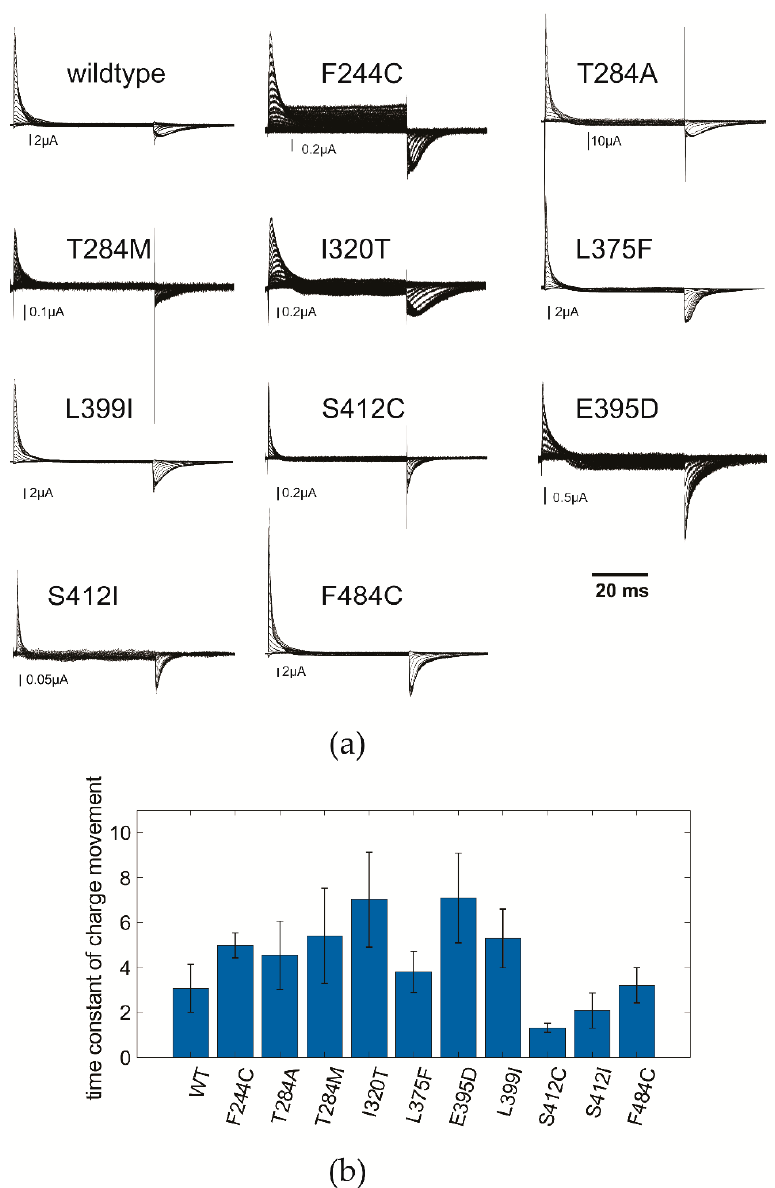
Figure 2. ( a ) Gating currents elicited from wildtype (WT) and EA1 mutants in response to depolarizing pulses from -90 mV to potentials between − 120 and +100 mV. F244C and I320T show leak currents in the C-type inactivated W434F mutant indicating impaired C-type inactivation [7] . ( b ) Time constant of gating charge activation at a potential +50 mV more positive than the midpoint of the QV (WT: 0 mV, F244C: 30 mV, T284A: 30 mV, T284M: 20 mV, I320T: 30 mV, L375F: 0 mV, E395D: 10 mV, L399I: 30 mV, S412C: 30 mV, S412I: 20 mV, F484C: 30 mV; n = 3–9).